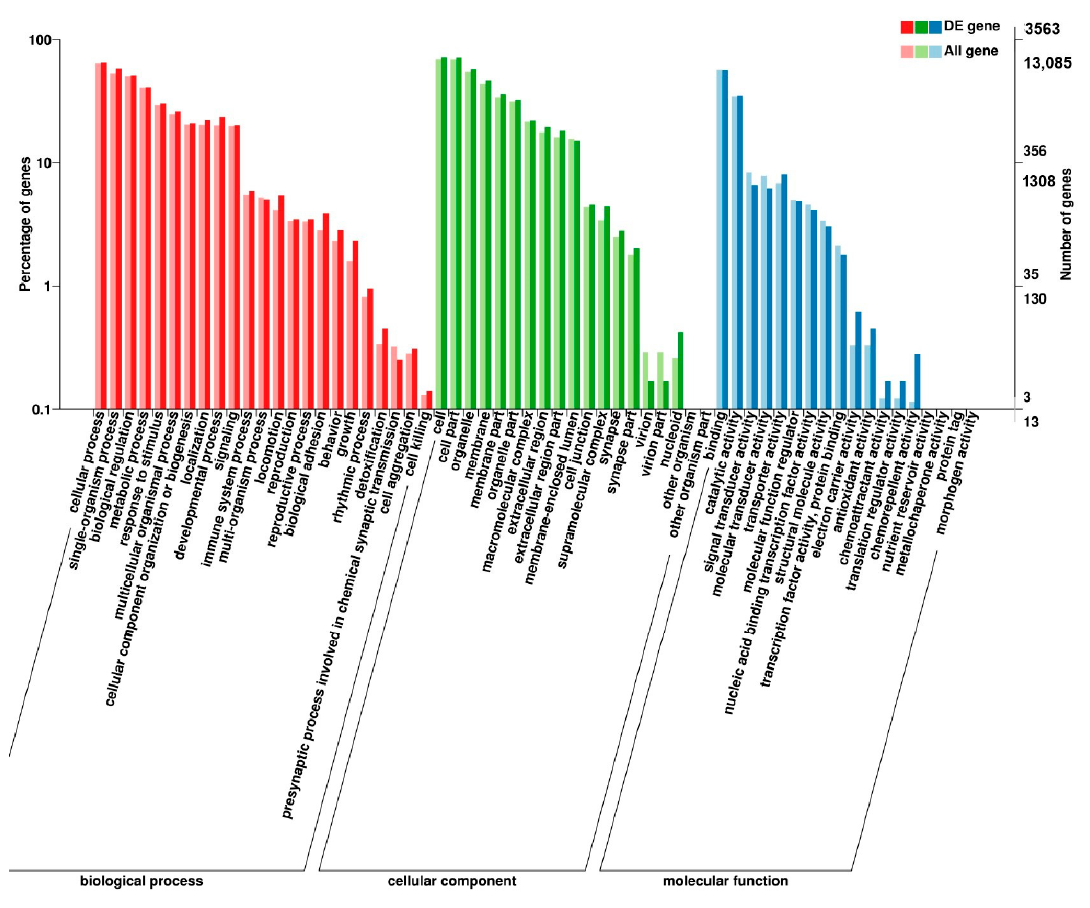
Figure 8. GO enrichment analysis of DEGs in leg muscle of